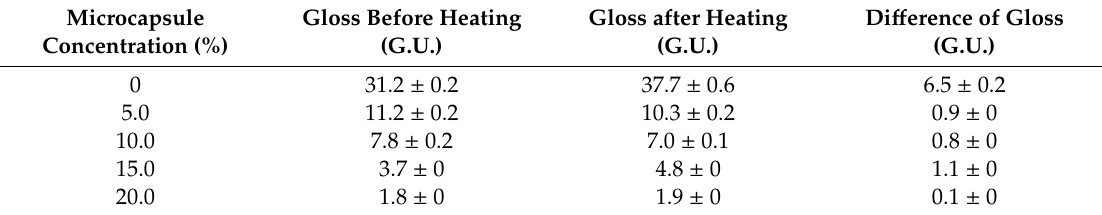
Figure 8. FTIR of paint films corresponding to microcapsule concentration. Table 7. E ff ect of microcapsule concentration (0.75:1 core-wall ratio) on 60 ◦ gloss.